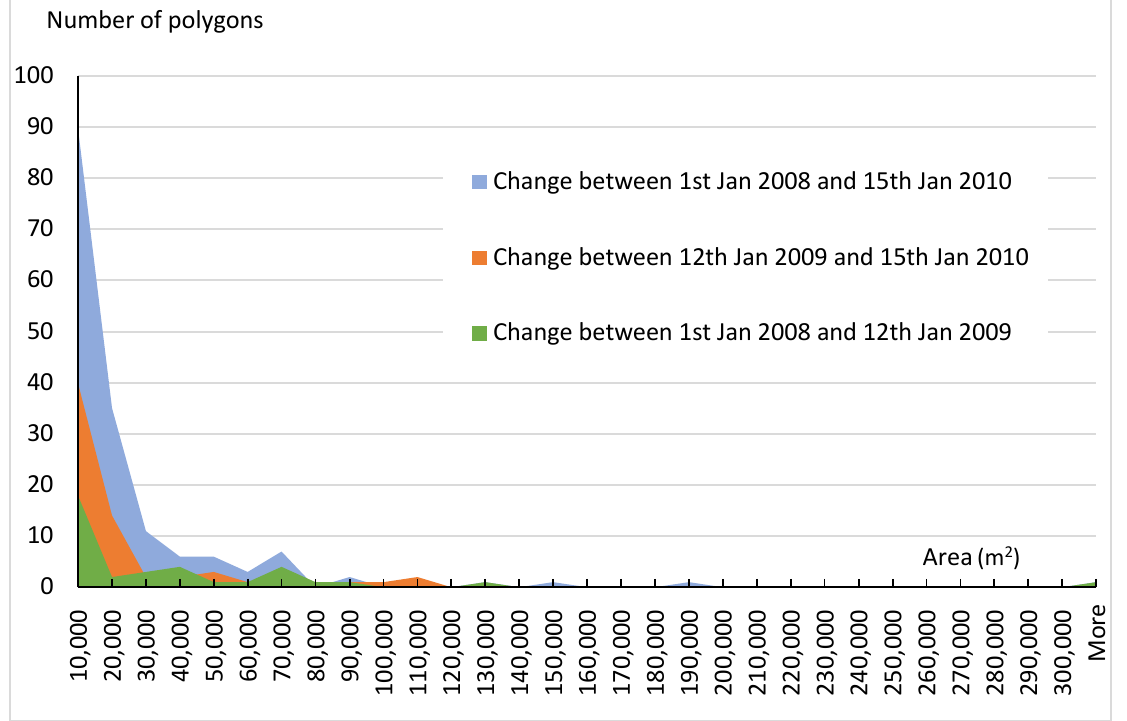
Figure 2. The histogram of change area in training data.